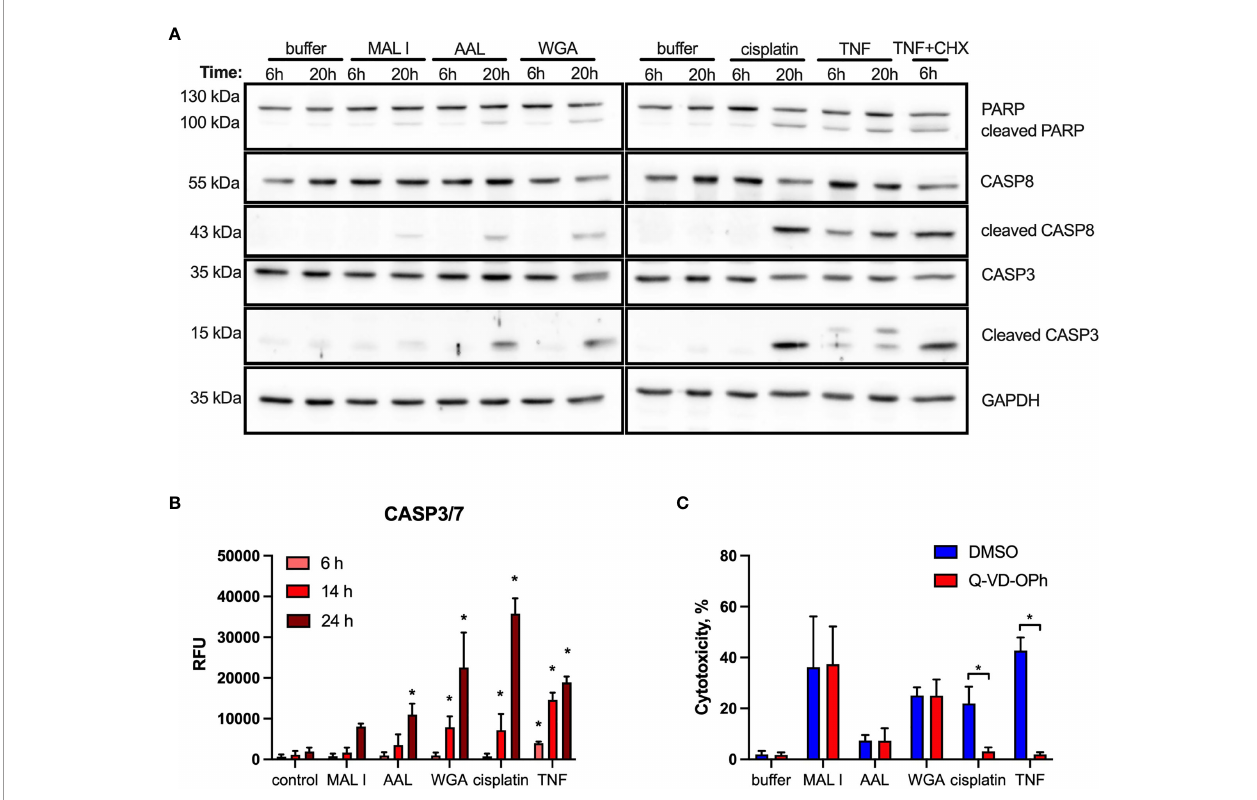
FIGURE 4 | Cleavage of PARP, caspase 8 and caspase 3 induced by lectin treatment of MC-38 cells. (A) Immunoblot analysis of poly-ADP-ribose polymerase 1 (PARP), procaspase 8, cleaved caspase 8, caspase 3 and GAPDH as a loading control in MC-38 lysates after treatment with either lectins or cisplatin and TNF controls for 6 and 20 h (B) Activation assay for caspases-3,7 (DEVDase activity) using fl uorogenic substrate. (C) Impact of caspase inhibition on cell death. MC-38 cells were treated either with DMSO or Q-VD-OPH broad spectrum caspase inhibitor in combination with lectins and respective controls. Data represent 6 replicates out of 2 independent experiments. *p < 0.05; one-way ANOVA with Bonferroni ’ s multiple comparison test (B) or unpaired two-tailed t-test (C)